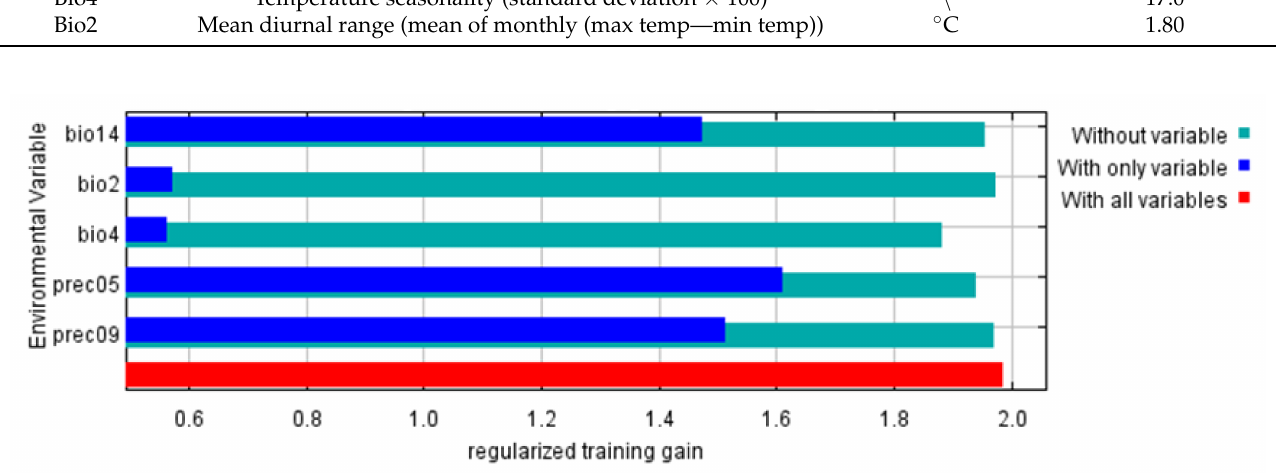
Figure 2. The results of the jackknife test of variable